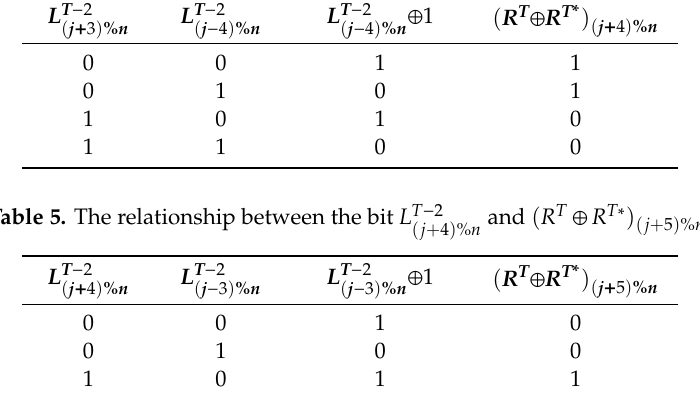
and ( R T ⊕ R T ∗ ) ( j + ( j + 3 ) % n